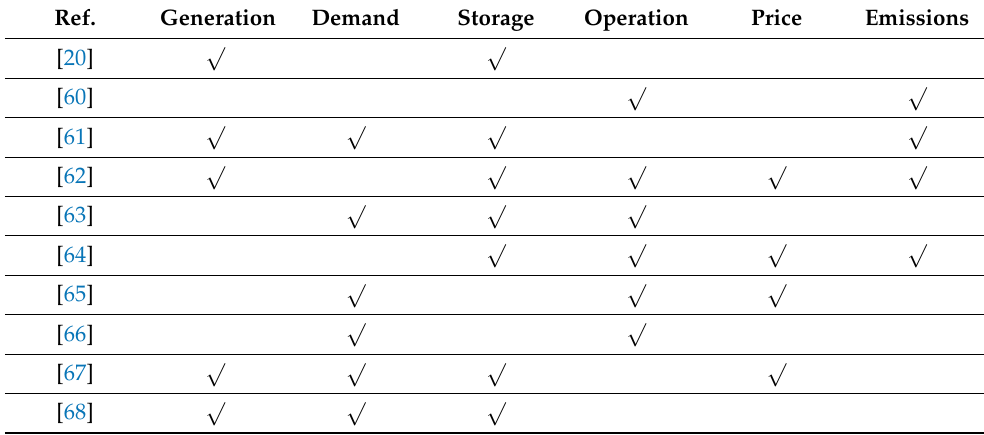
Table 1. Summary of commonly used constraints.